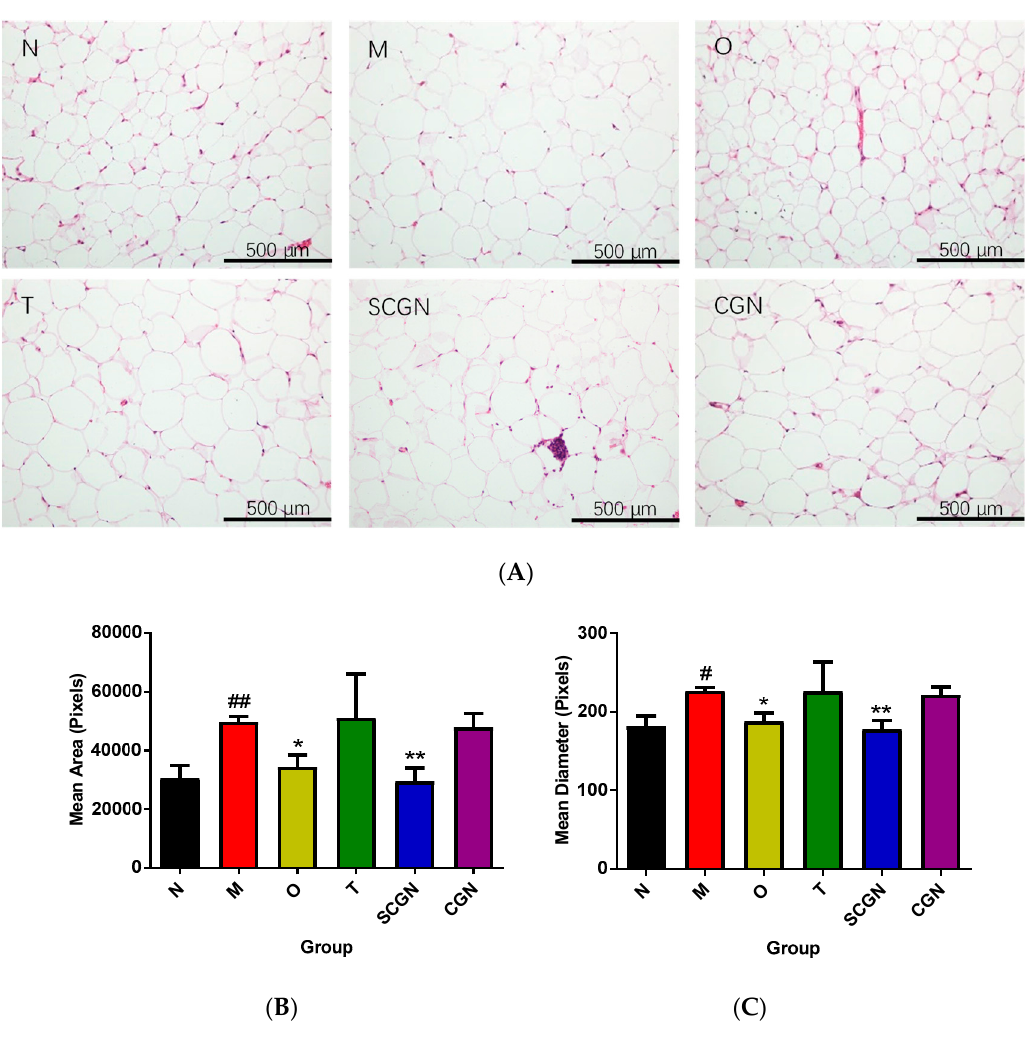
Figure 2. ( A ) Histology (200× magnification), ( B ) size, and ( C ) diameter of adipocytes in mice. N = Normal, M = Model, O = Orlistat, T = Whole Kappaphycus , CGN = Carrageenan, SCGN = Sans-carrageenan fraction. Values are given as mean ± SEM, n = 7. Statistical significances were calculated using one-way ANOVA with Tukey post-test (# and * p < 0.05, ## and ** p < 0.01); # denotes versus N, * denotes versus M.